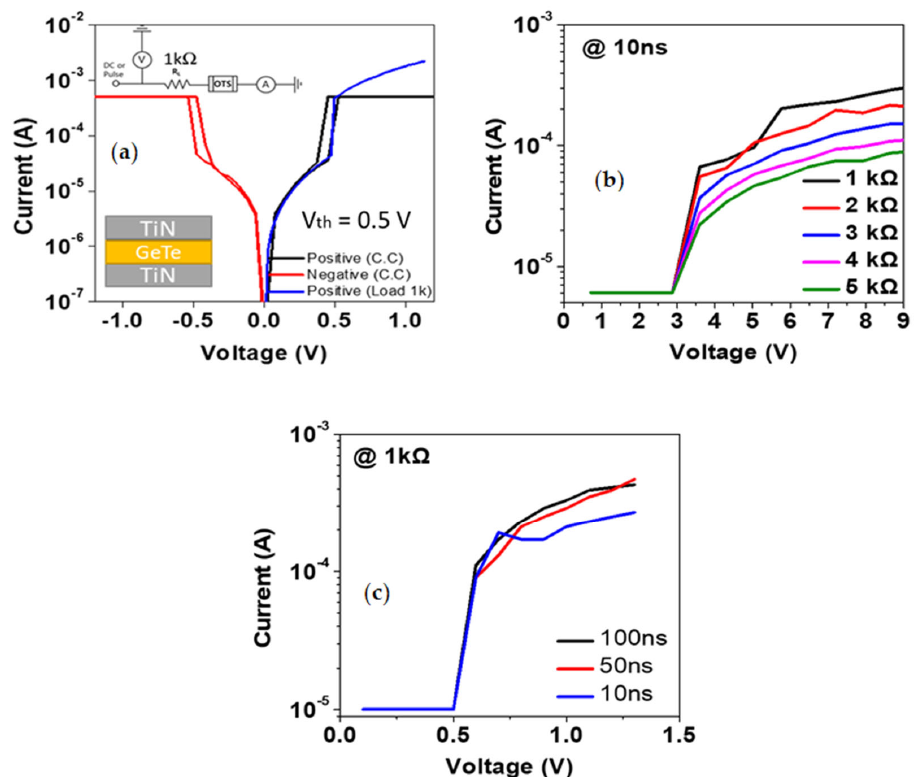
Figure 2. ( a ) DC I–V characteristic curves of the BE TiN/OTS (GT)/TE TiN device. The black line